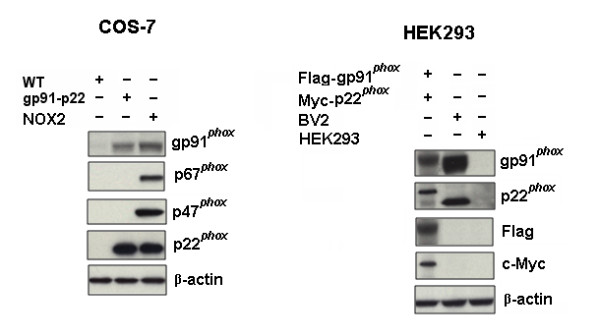
Gp91phox-p22phox complex is expressed in COS-7 and HEK293 cells. A. Western-blot analysis for gp91phox, p22phox, p47phox and p67phox in COS-7-gp91phox-p22phox and COS-7-NOX2 cells. B. Western-blot analysis for gp91phox and p22phox in HEK293 cells. Briefly, 1 × 106 HEK293 cells were seeded into 6-well plates. Flag-gp91phox and Myc/His-p22phox expression plasmids were co-transfected into HEK293 cells using Lipofectamine 2000 according the commercial protocol. After 48 hours of expression, cells were collected for western-blot detection.